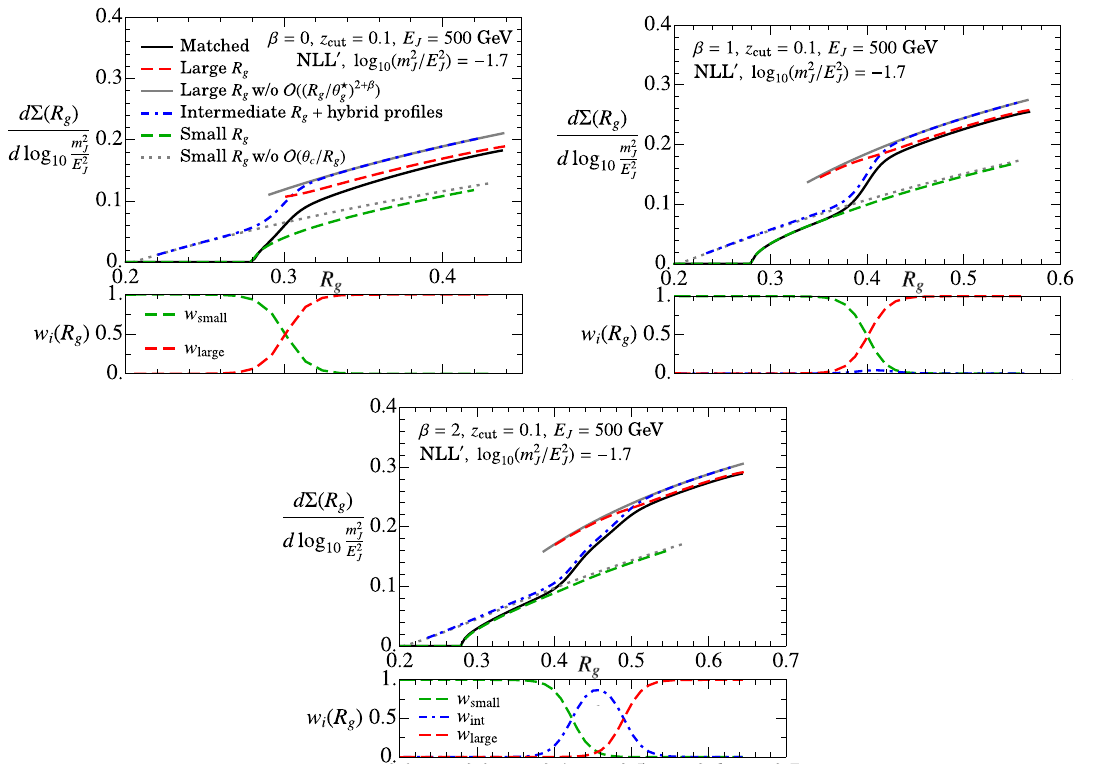
Figure 6 . The matching prescription smoothly interpolating between the three EFT regimes is shown for the distribution cumulative in R g , at NLL 0 accuracy, for different values of β and a fixed value of m J . The large R g (red dashed) and small R g (green dashed) predictions include fixed-order corrections that are relevant in the respective plotted range; the profile-improved intermediate pre- diction (blue, dot-dashed) does not yet include these corrections while resumming large logarithms in the central region. We obtain the matched result (solid black) by weighting the three curves with the exponents w i ( R g ) shown in the bottom panels, and subtracting the overlap (grey) as described in the